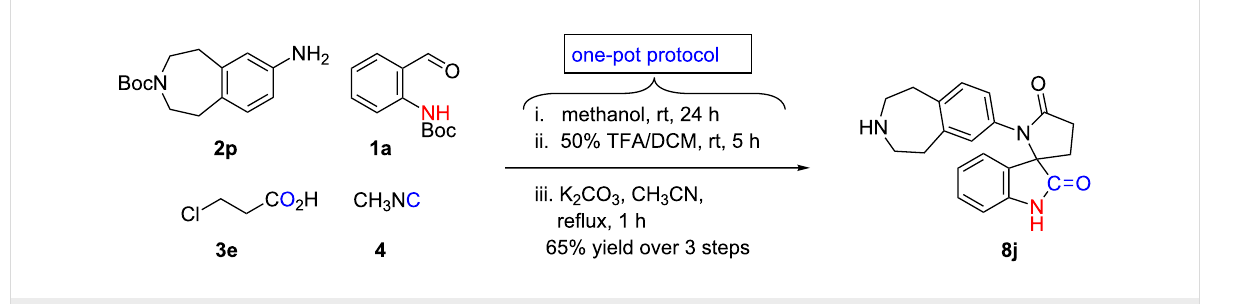
Figure 3: Small molecule library of spiro[indoline-3,2'-pyrrolidine]-2,5'-dione analogs.